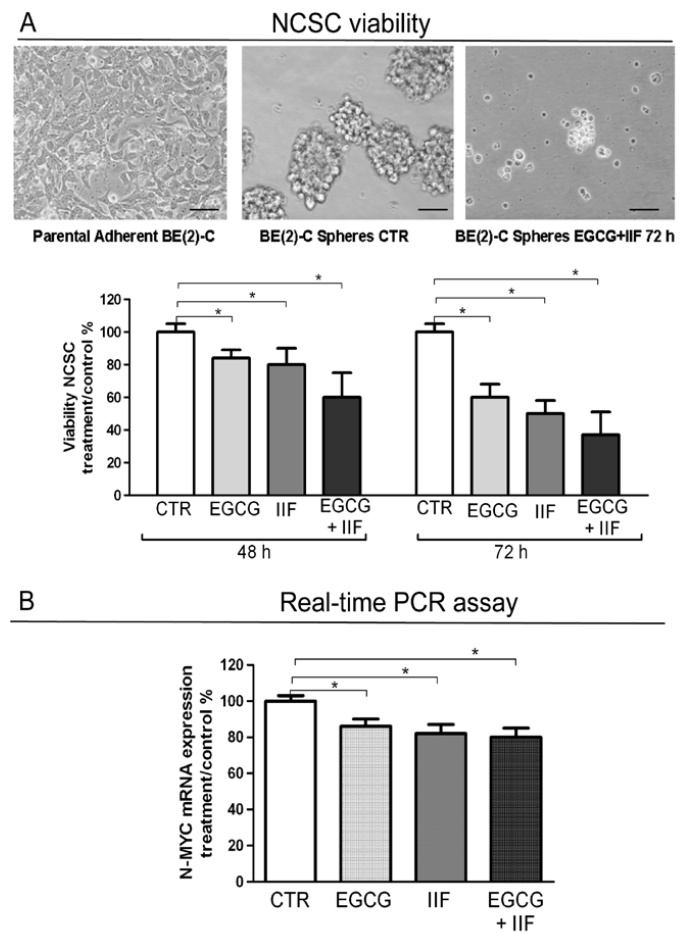
Figure 9. EGCG and IIF treatments limited sphere formation and N-MYC expression in BE(2)-C neuroblastoma cells. ( A ) Neural cancer stem cells (NCSC). Parental adherent BE(2)-cells were grown in non-adherent serum-free conditions to develop spheres for 72 h (CTR) and treated with 20 μg/mL EGCG and 10 μM IIF, individually and in combination for 72 h. Viability was evaluated by Trypan blue assay. ( B ) N-MYC mRNA expression was evaluated by qPCR in control (CTR) and treated cells. GAPDH was used as a loading control. The results are expressed as the average ± SE of three independent experiments. * p < 0.05. n.s.: not